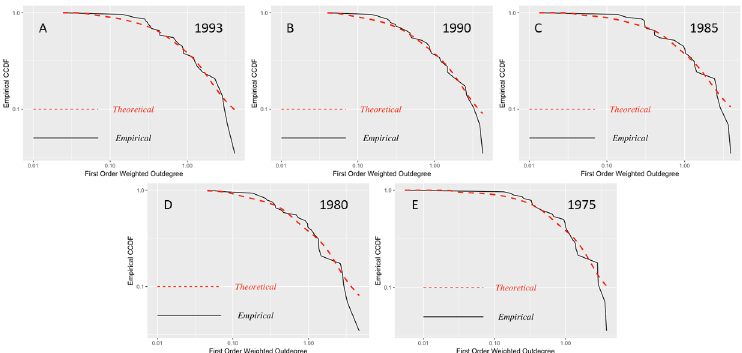
Fig 6. CCDF first-order weighted outdegree input-output matrices1975–1993. (A) Matrix 1993, 34 economicsectors. (B) Matrix 1990, 34 economicsectors. (C) Matrix 1985, 34 economicsectors. (D) Matrix 1980, 34 economicsectors. (E) Matrix 1975, 34 economicsectors. Log-logplots of the empiricalcounter- cumulative density functions (CCDF) of the weightedfirst-order